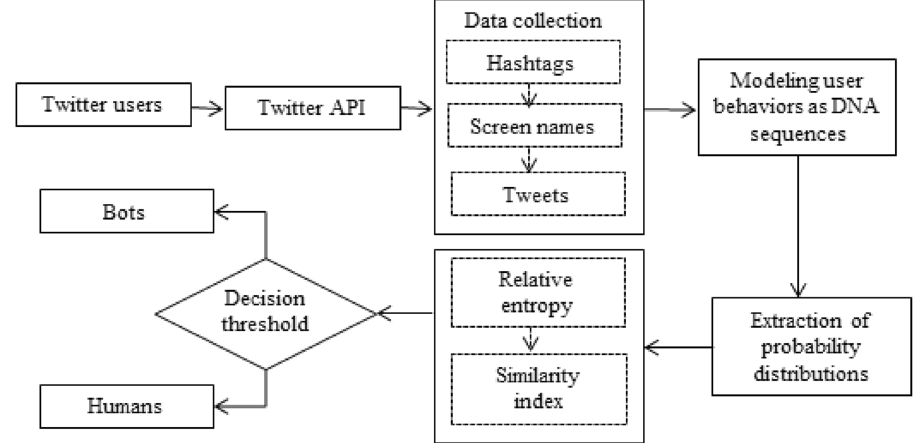
Figure 1. Experimental design of proposed